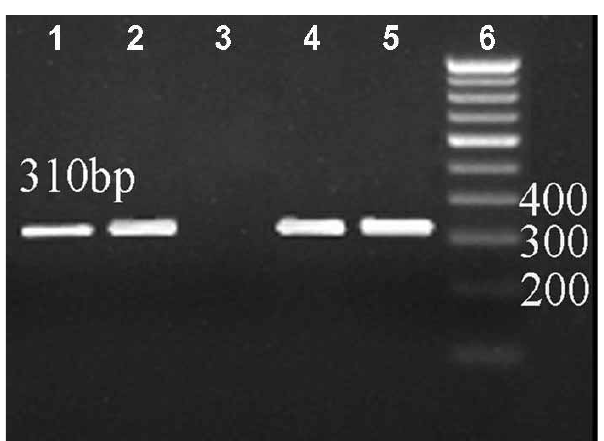
Figure-6: PCR amplification of overlapping segments of gene. mec